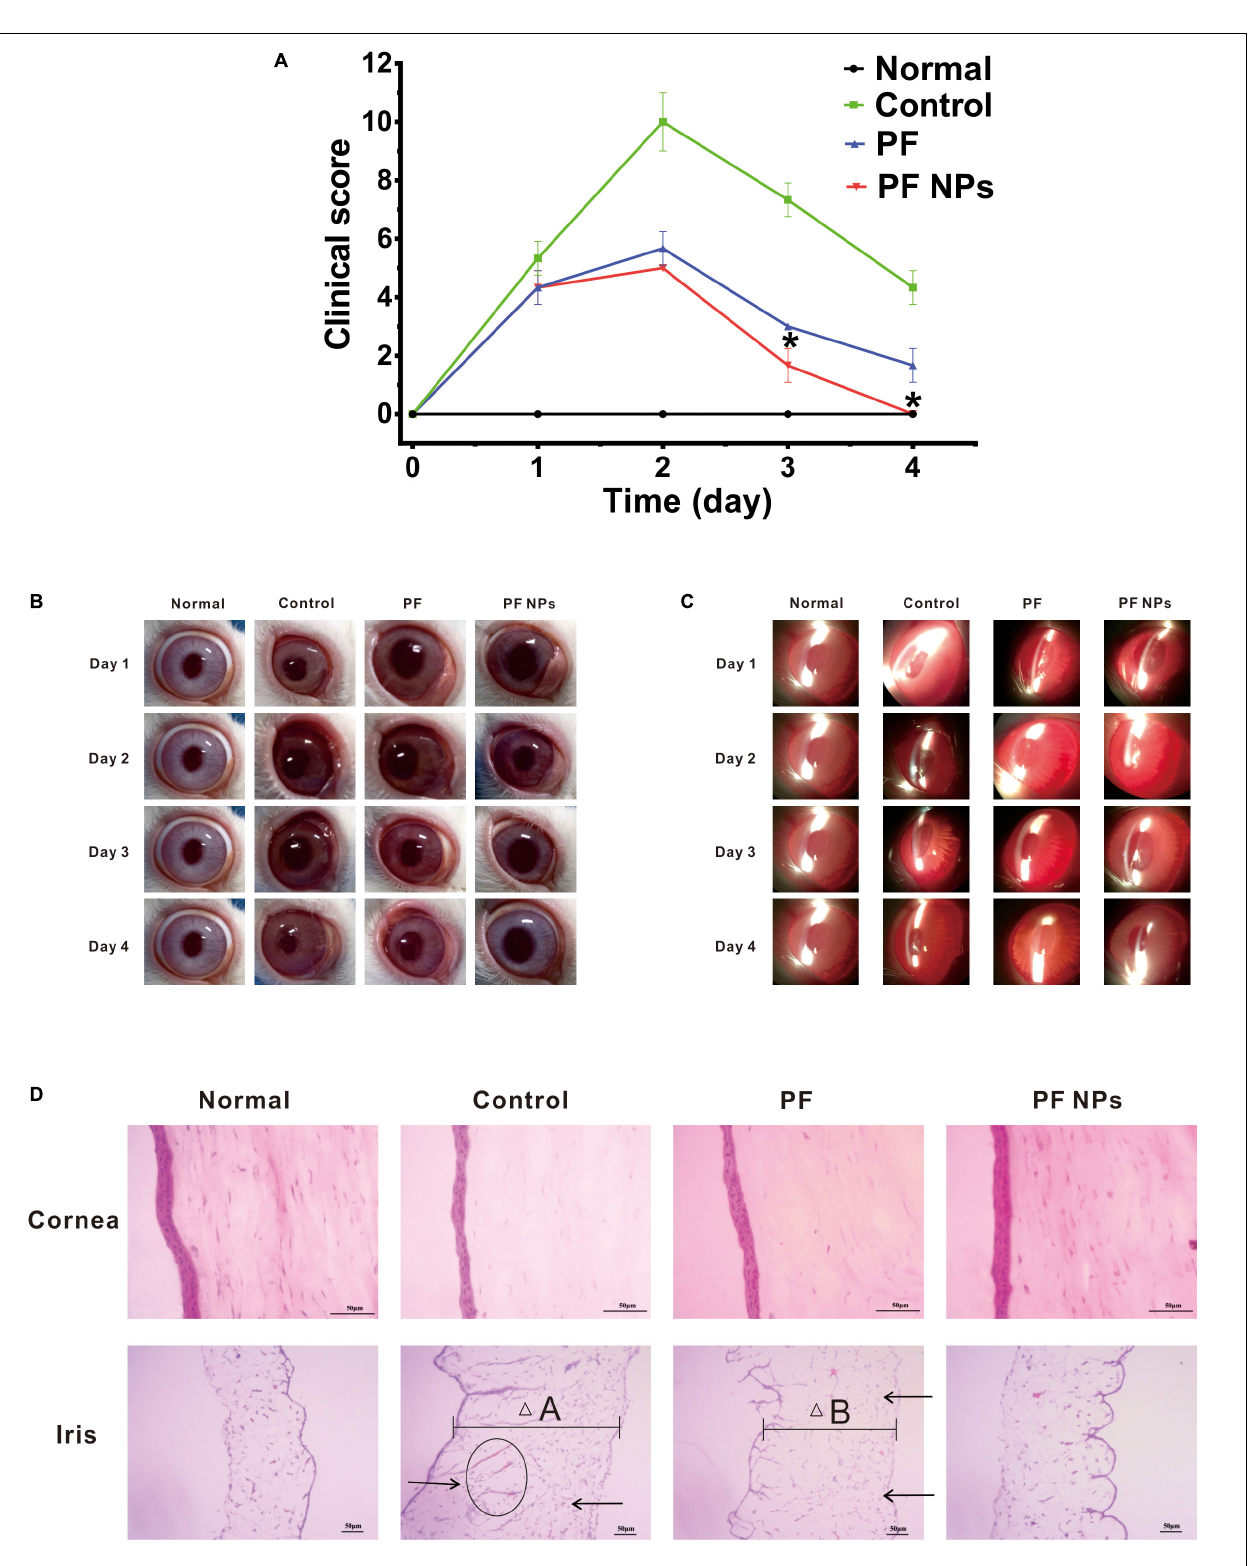
FIGURE 7 | In vivo anti-inflammatory tests. (A) Score alteration after the infected eyes were treated with pure PF or PF NPs (1 mg/mL) for 4 days. The control eyes were treated with PS. *Indicates a statistically significance ( p < 0.05). Ocular observation with eyes (B) and a silt lamp (C) were performed. (D) HE staining. Scale bar, 50 µ m. Arrows indicate infiltration of inflammatory cells. The ellipse indicates neovascularization. “ (cid:77) A” and “ (cid:77) B” indicate tissue widths.